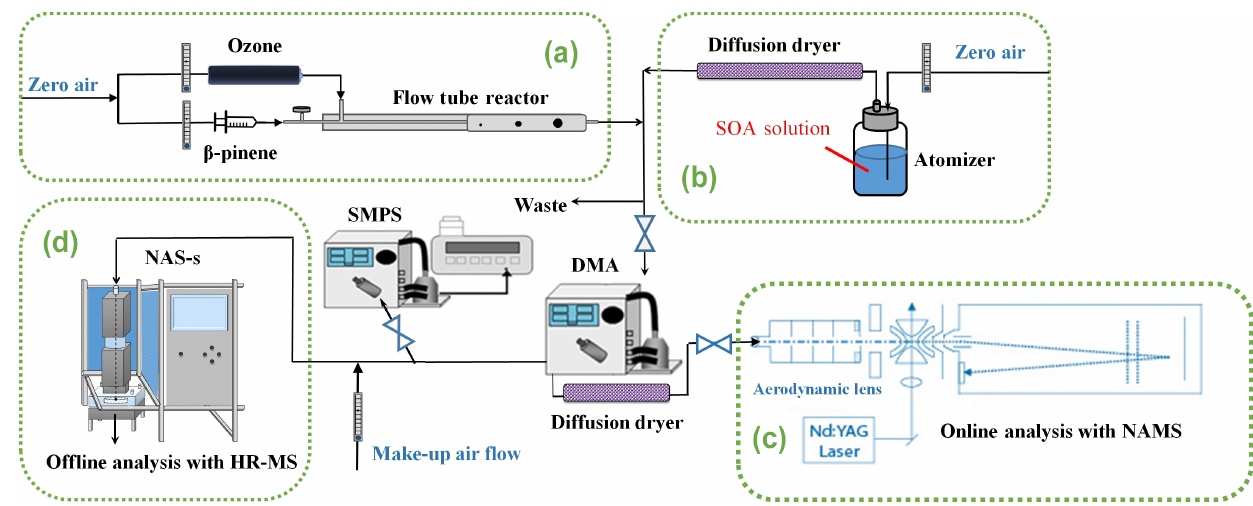
Figure 1. Schematic of the experimental workflow. SOA is produced either directly from the flow tube reactor (a) or re-aerosolization from an atomizer (b) . Analysis is performed online by NAMS (c) or offline by HR-MS after sample collection with NAS-s (d)